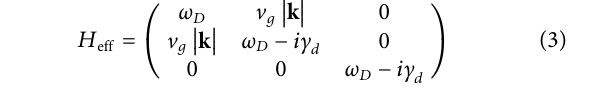
Frontiers in Physics |